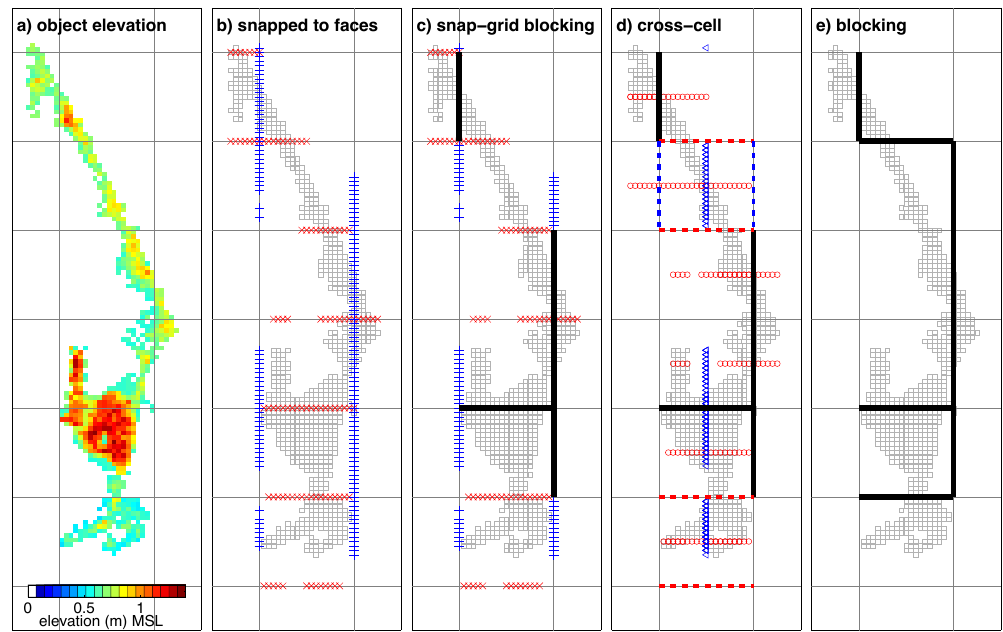
Figure 5. Blocking caused by a large object similar to Fig. 4 for frames (a) through (c) . In (d) the remaining G y and G x are transformed to cell-center H y and H x blocking shown with red ◦ and blue (cid:52) , and different possible blocking paths are illustrated with dashed lines; (e) shows final blocking paths that are